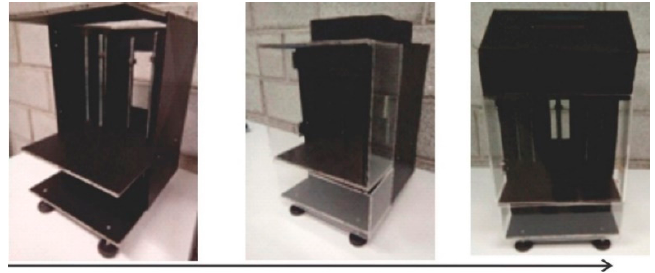
Figure 12. Structure assembly process.